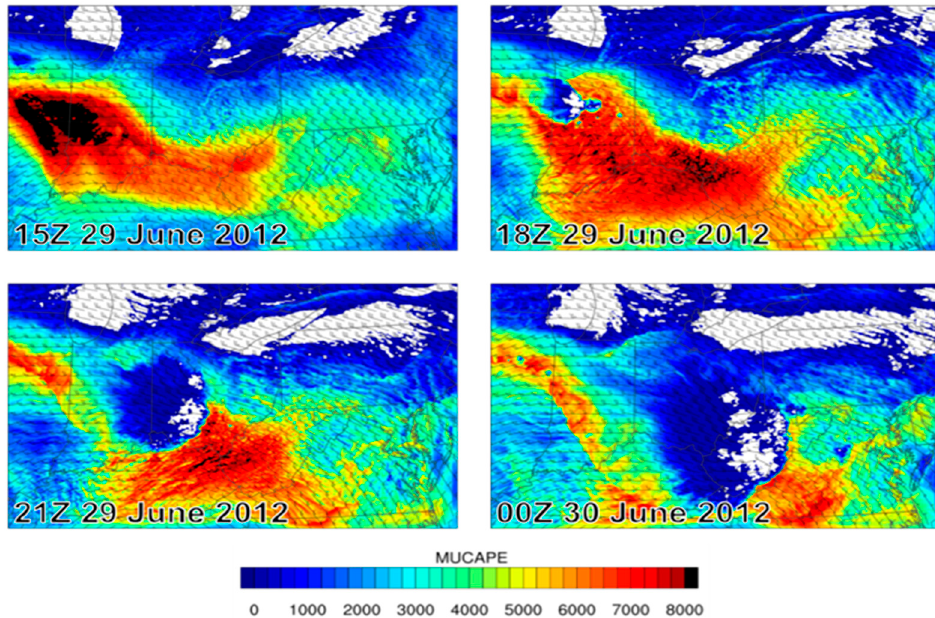
Figure 19. WRF-ARW 2 km simulated maximum CAPE (MUCAPE, fill in J kg − 1 between 0–3000 m AGL) and 500 hPa wind barbs (kts) for ( top left ) 15Z 29 June, ( top right ) 18Z 29 June, ( bottom left ) 21Z 29 June, and ( bottom right ) 00Z 30 June